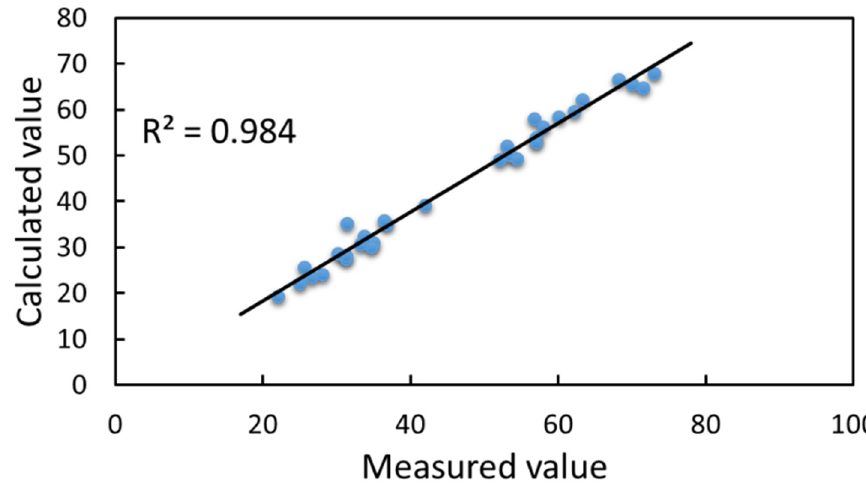
Figure 23. Linear relationship between calculated and measured values of plant height.